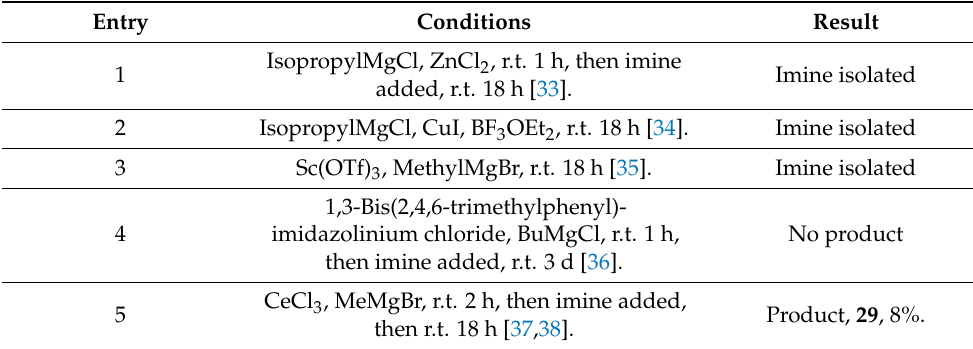
Table 7. Investigations into possible alternatives to the Grignard